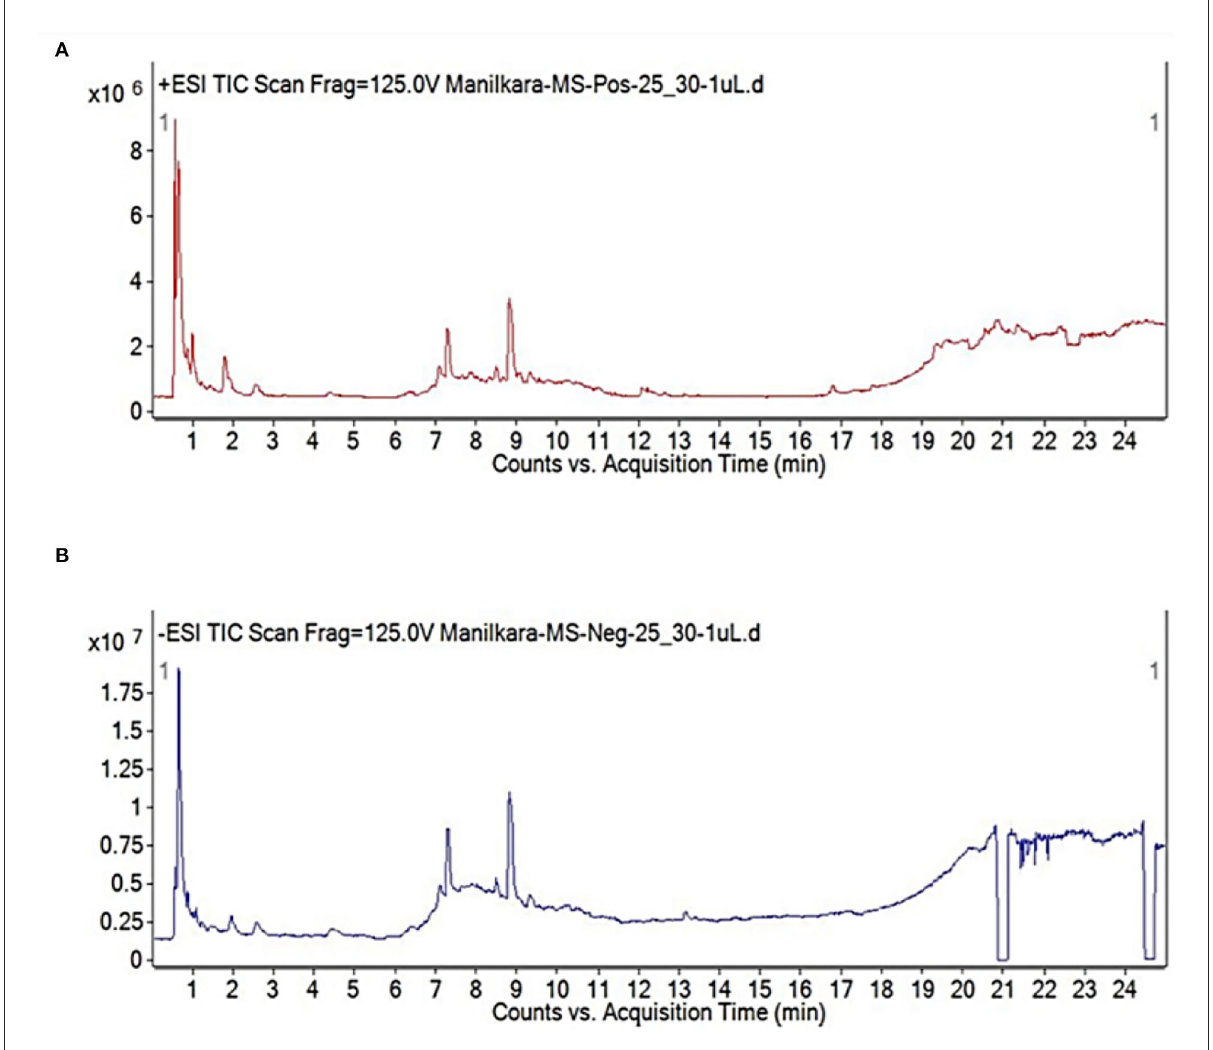
FIGURE1 Chromatogram of aqueous leaf extract by LC-QTOF MS in (A) positive and (B) negative ionization modes (Tamsir et al., 2020).